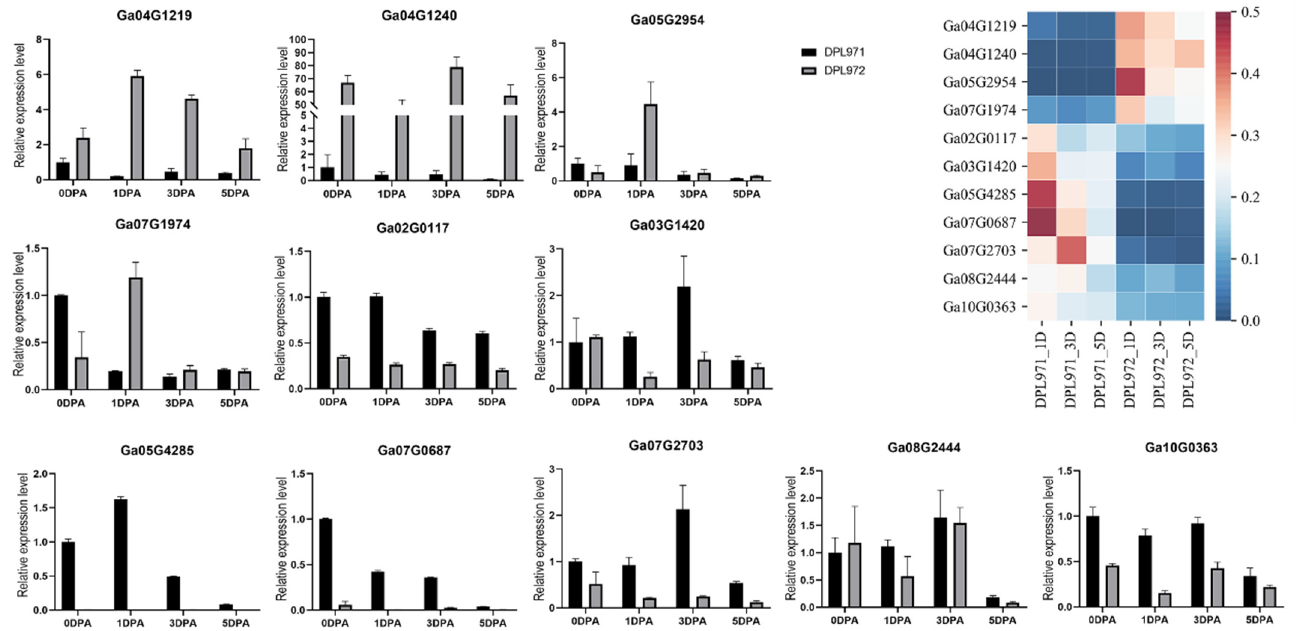
Figure 2. Validation of DEGs identified from transcriptome analysis with qRT-PCR. The heatmap on the top right of figure represents the relative transcription abundances (based on FPKM).